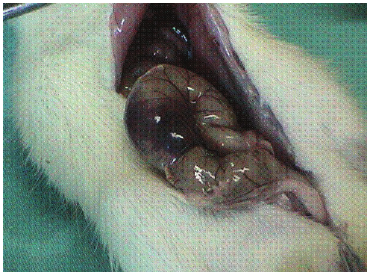
Figure 1 - The appearance of local hematoma on the cecum in Group 4 (t-PA group)